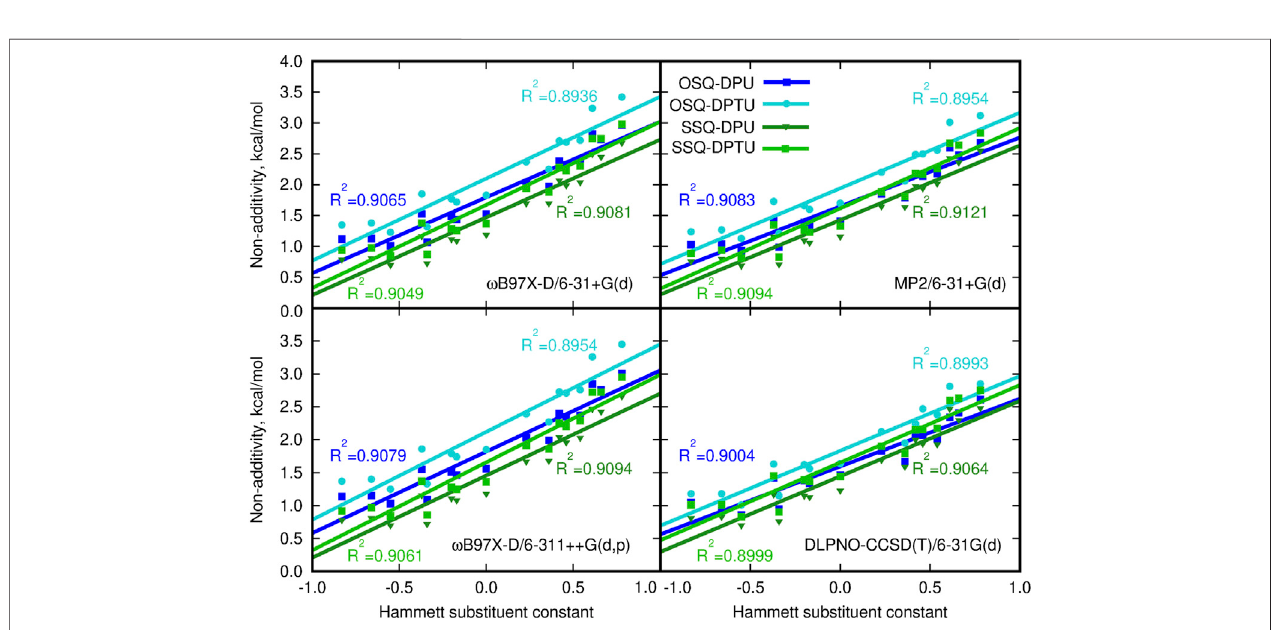
FIGURE 8 | Non-additivity in the supermolecular interaction energy versus the Hammett substituent constant.